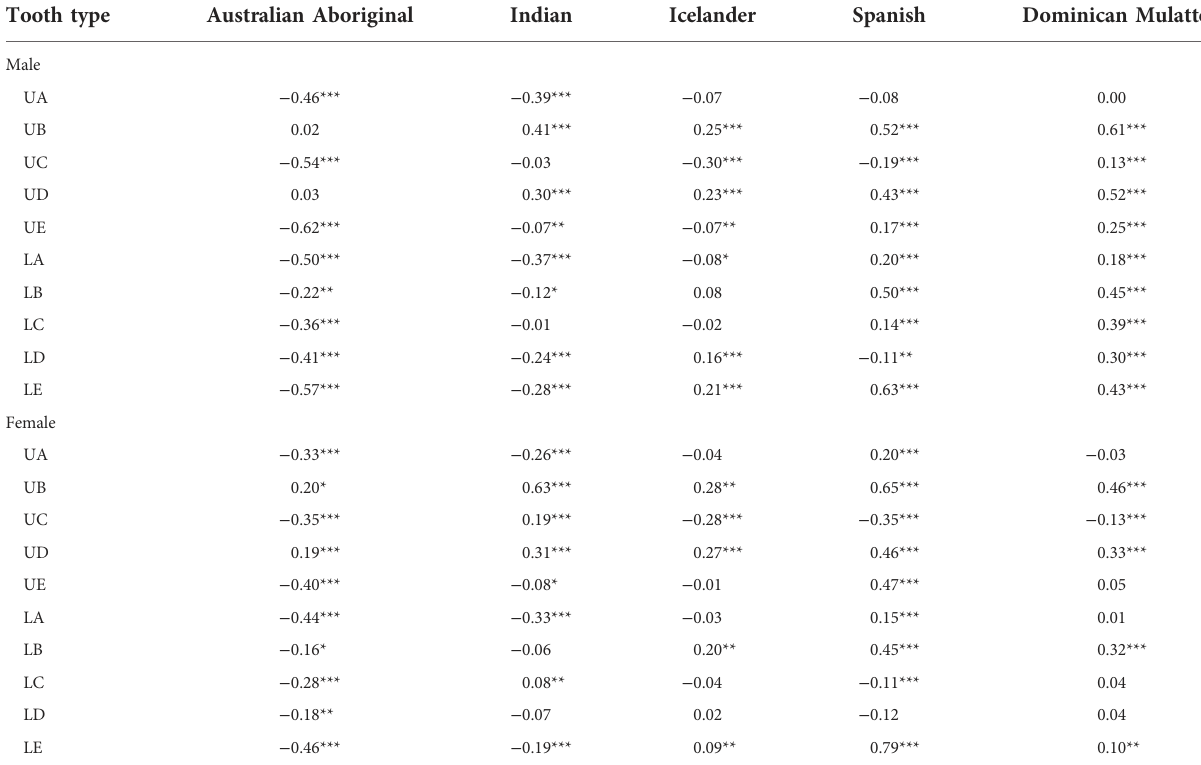
TABLE 10 Difference (mm) between the buccolingual diameter of the primary teeth of northwest Chinese and those of the other populations. Tooth